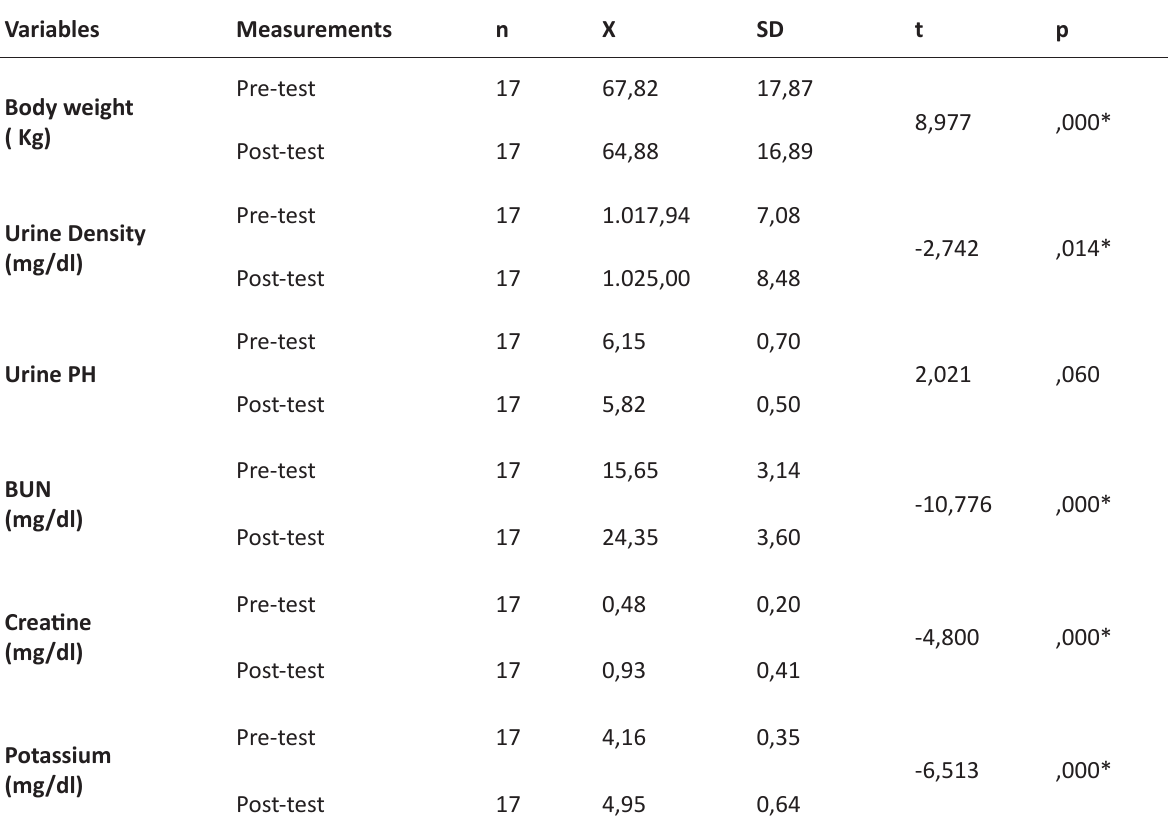
Table 2. Values of Judokas 21 Days Before and During Competition (Mean ± SD)